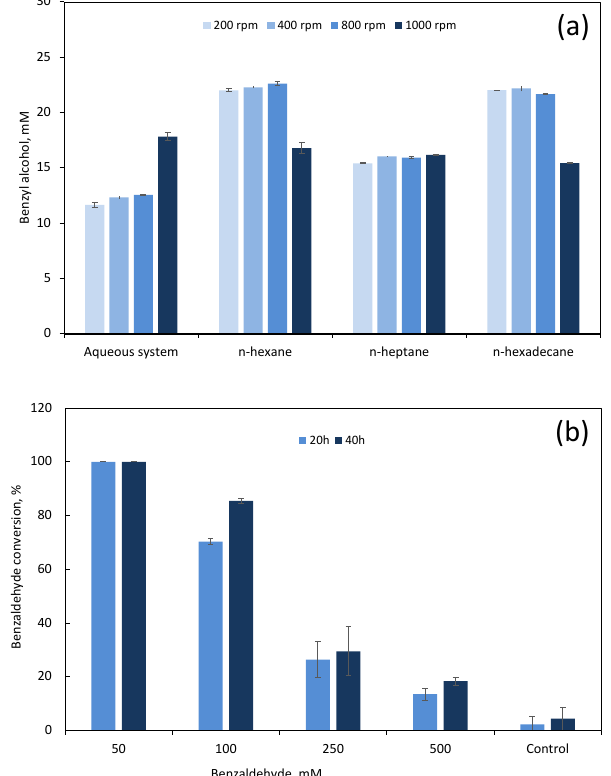
Figure 3. Conversion of benzaldehyde to benzyl alcohol by G. arilaitensis 232 cells in two-phase systems. ( a ) Production of benzyl alcohol using 3 different water immiscible organic solvents as com- pared with the aqueous system, at different stirring speeds (200 to 1000 rpm). ( b ) Effect of the initial benzaldehyde concentration on benzaldehyde conversion at 20 and 40 h using the two-phase system with n- hexane as organic solvent. Control assays were carried out without cells and 100 mM of benzaldehyde. Results are the average of three independent bioconversions. Data are presented as mean ± standard deviation.